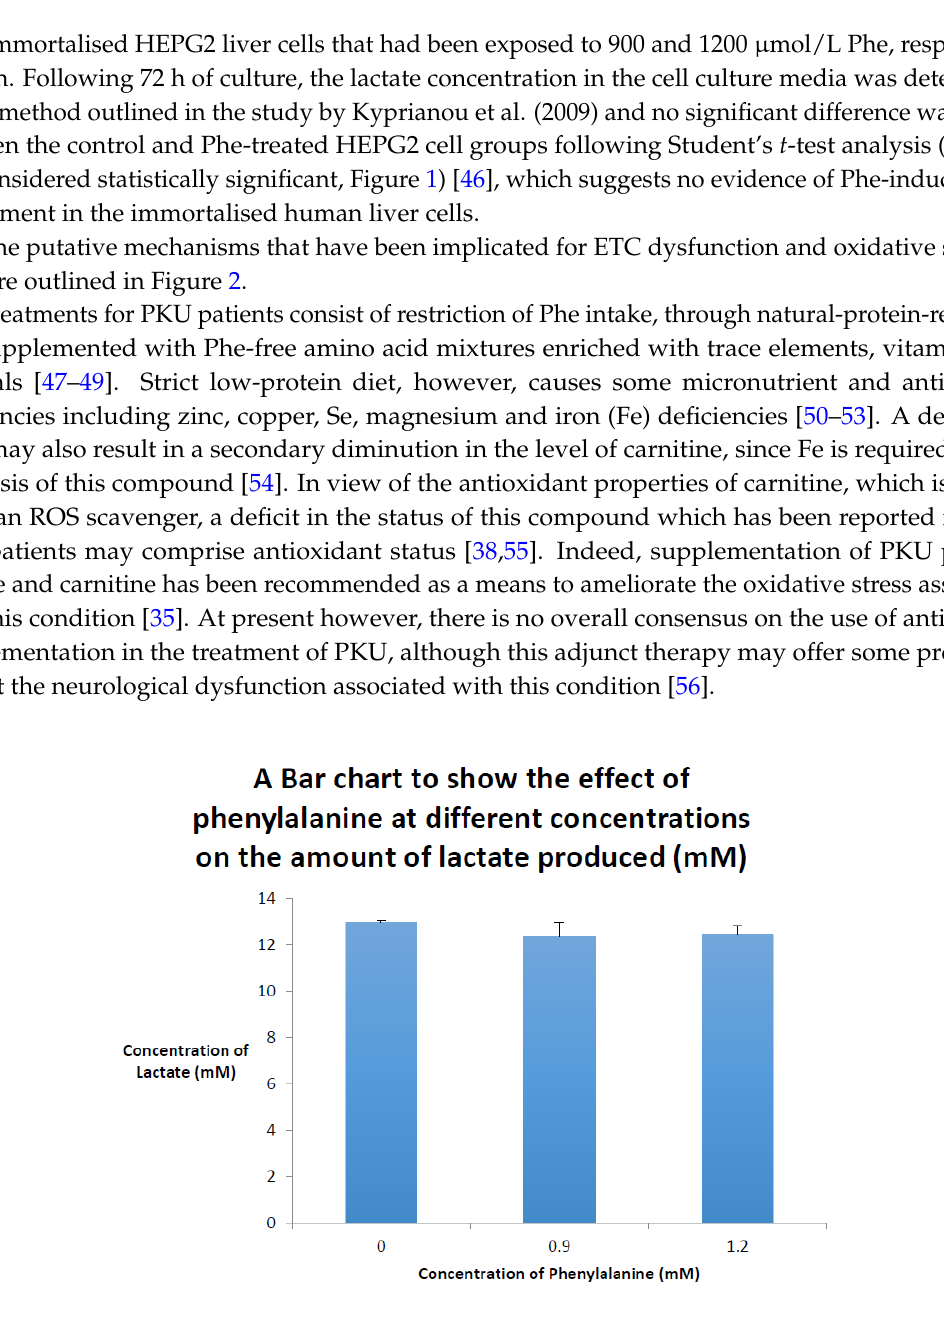
Figure 1. Bar chart displaying the mean cell culture lactate concentrations determined following culture of human HEPG2 liver cells for 72 h with 0.9 and 1.2 mM phenylalanine, respectively. Results are expressed as the mean and standard deviation of four determinations.